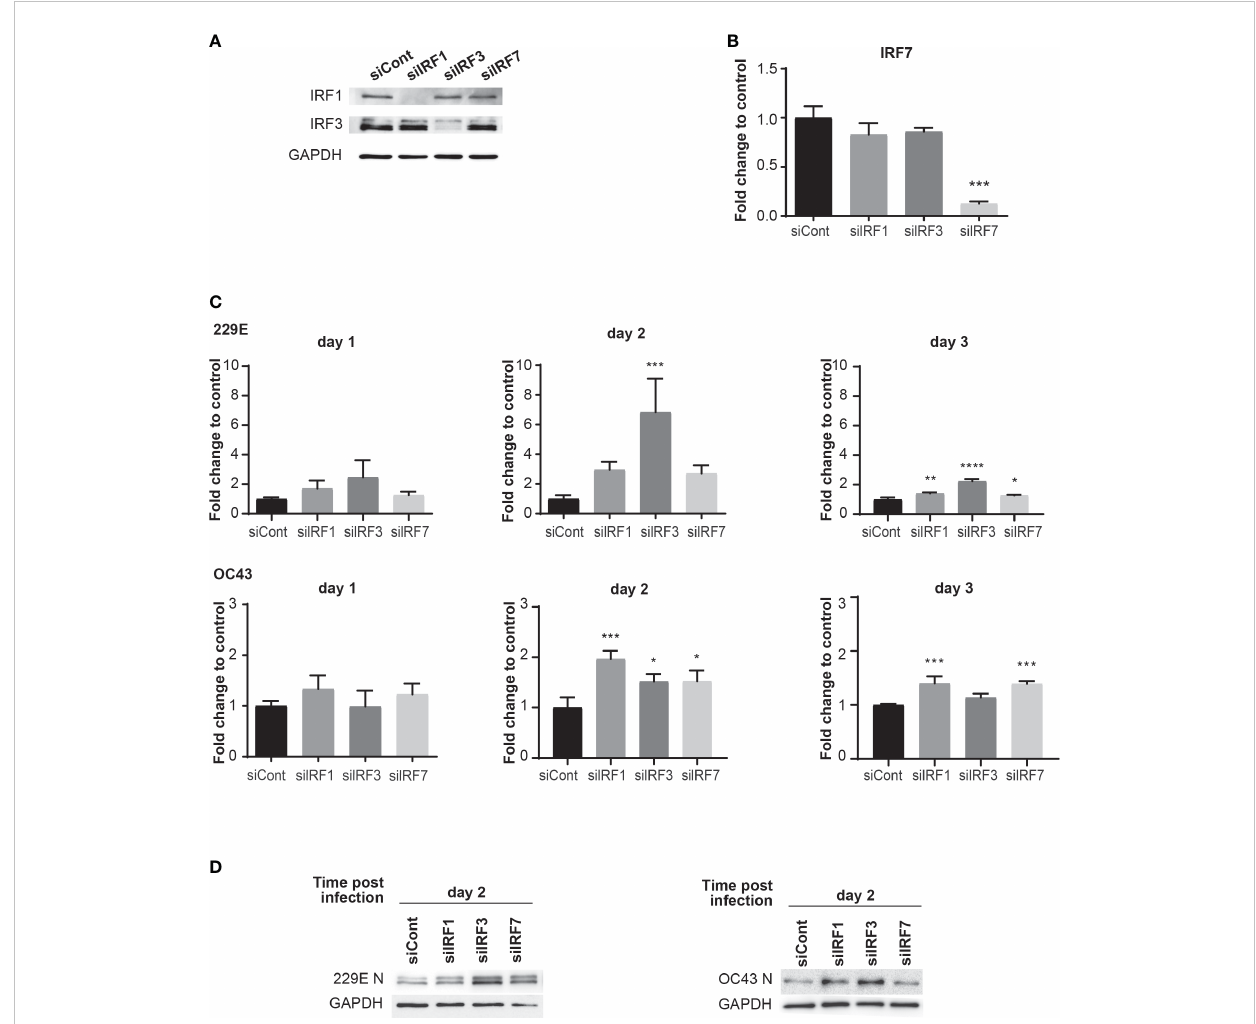
FIGURE 4 Knockdown of IRFs promotes human coronavirus infection. MRC5 cells were transfected with control siRNA (siCont), IRF1 siRNA, IRF3 siRNA or IRF7 siRNA oligoes (5 pmol) using Lipofectamine RNAiMAX transfection reagent. The knockdown of IRFs expression was con fi rmed by western blot analysis for IRF1 and IRF3 (A) and RT-qPCR for IRF7 (B) . MRC5 cells were then infected with 229E or OC43 at MOI of 0.01. (C) The amounts of viral RNA were measured by RT-qPCR (n=3). (D) The amounts of viral protein were determined by western blot analysis using antibodies against 229E N protein, OC43 N protein and GAPDH. For RT-qPCR analysis, the transcription level for each gene was fi rst normalized to GAPDH expression level. The fold change to control indicates the fold change of the expression level for IRFs siRNA transfected samples to that of the control siRNA transfected samples. *p<0.05, **p<0.01, ***p<0.001, ****p<0.0001, Two-way